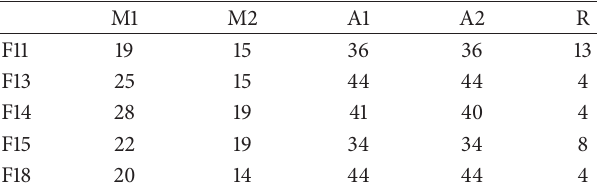
Table 5: Number (percent) of clones in each family and trial with acceptable chip color scores (4.5 or